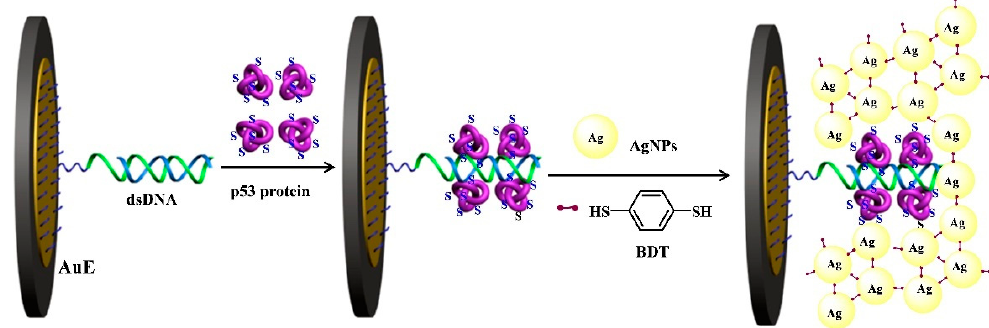
Figure 7. Schematic representation of the biosensor for the detection of wild-type p53 protein by the in situ formation of AgNPs networks for signal amplification [70]. Copyright 2020 Elsevier B.V.